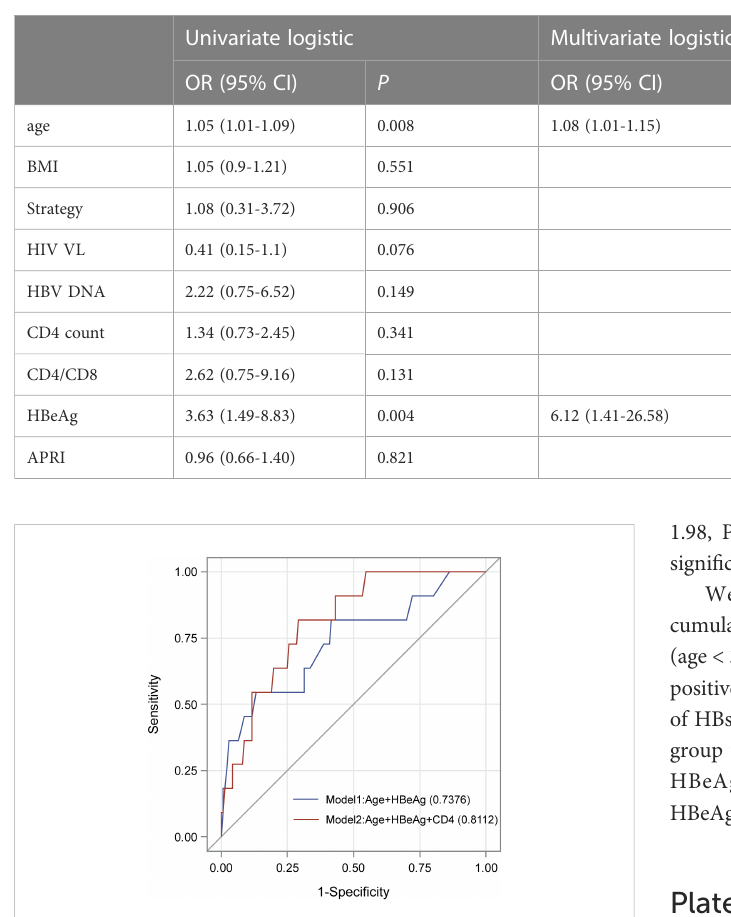
FIGURE 2 AUC of the two models in the multivariate logistic regression.